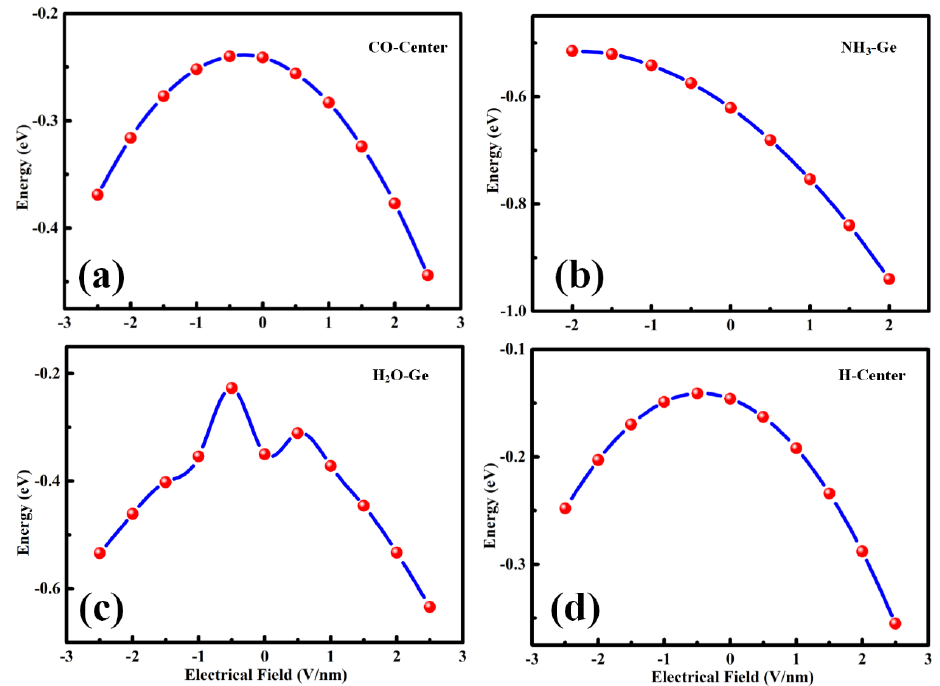
Figure 10. The calculated adsorption energy as a function of applied external electric field (E-field) for ( a ) CO-center, ( b ) NH 3 -Ge, ( c ) H 2 O-Ge, and ( d ) H 2 -center adsorbing at SiGe monolayer, and the external E-field is perpendicular to the plane of SiGe monolayer with its positive direction aligned upward toward the coordinate axes.